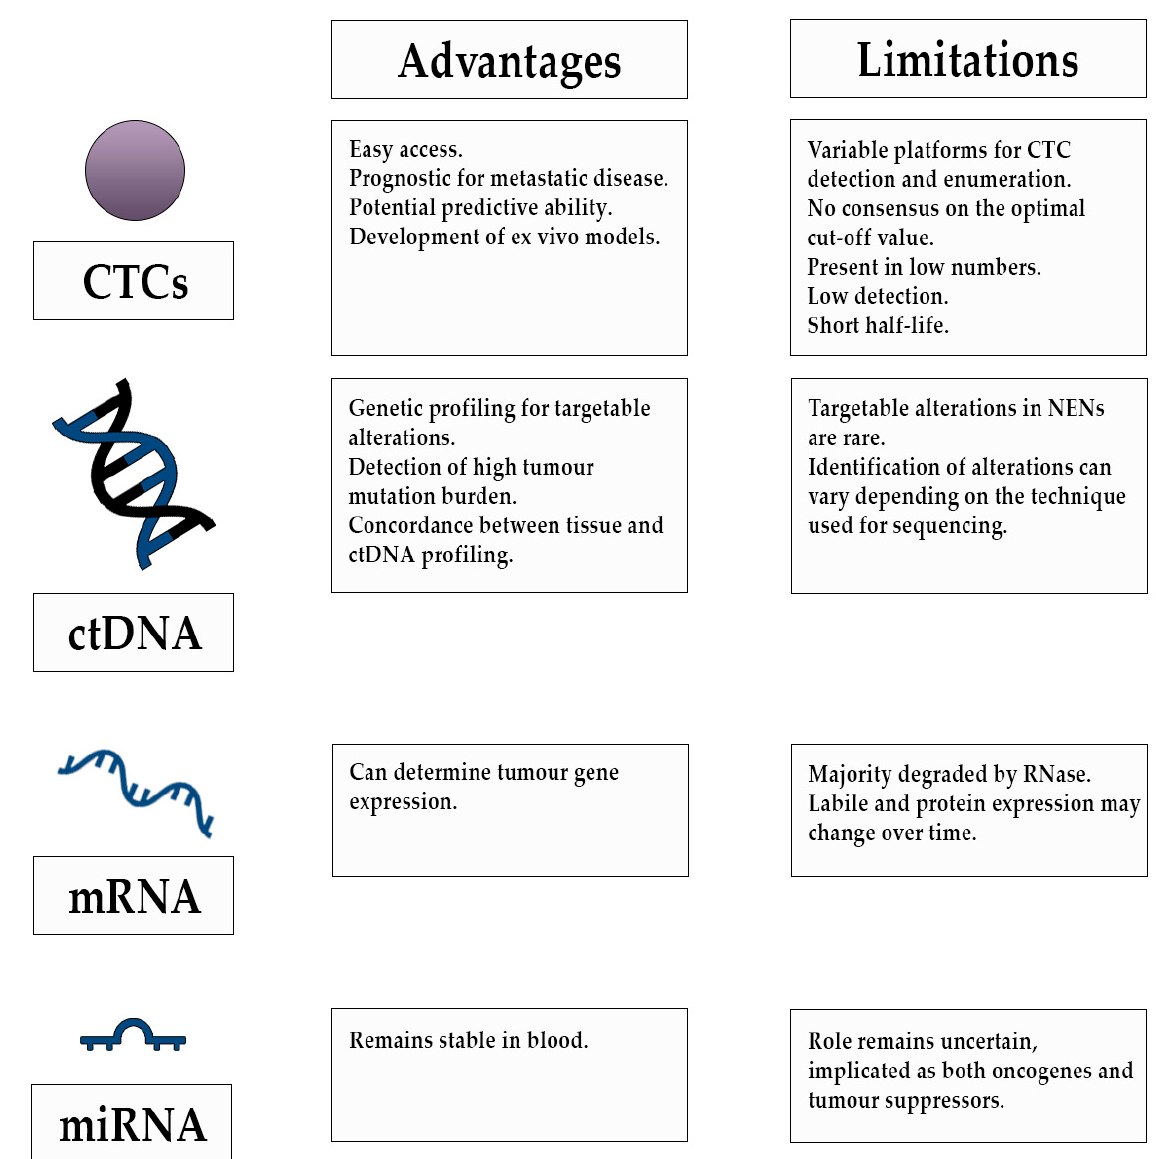
Figure 2. Advantages and limitations of circulating tumour marker use in the management of patients with NENs. CTCs: circulating tumour cells, ctDNA: circulating tumour DNA, mRNA: messenger RNA, miRNA: micro RNA, NENs: neuroendocrine neoplasms .